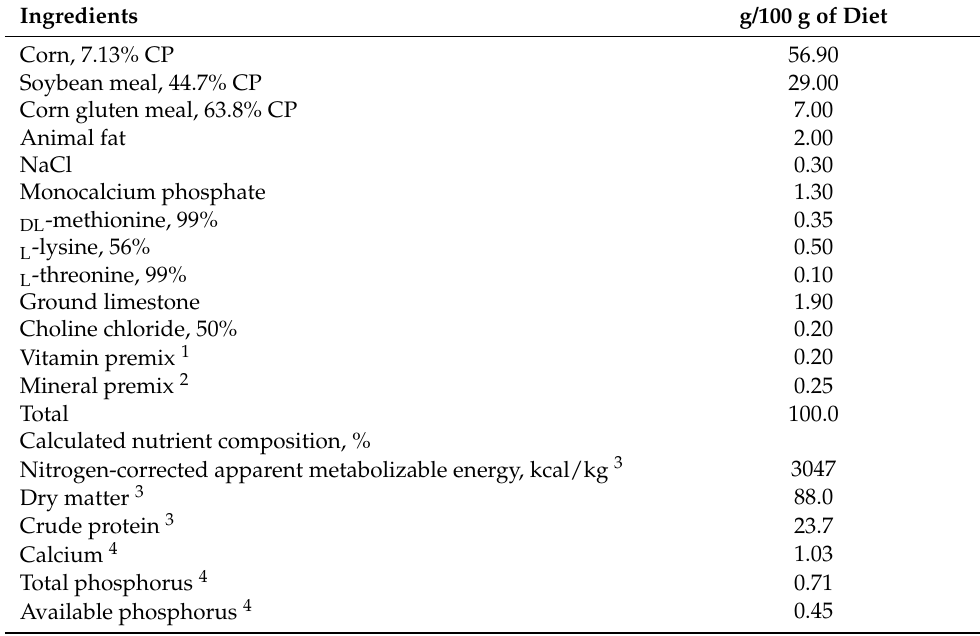
Table 1. Ingredient and nutrient composition of the basal